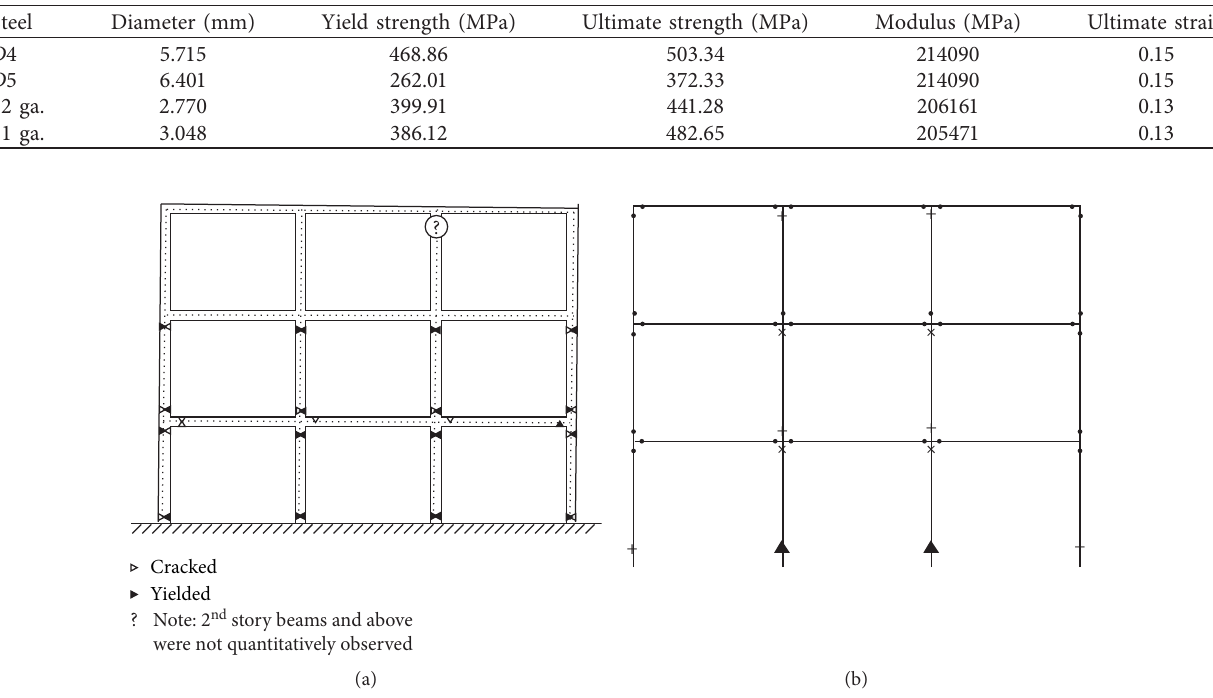
Table 2: Steel properties.